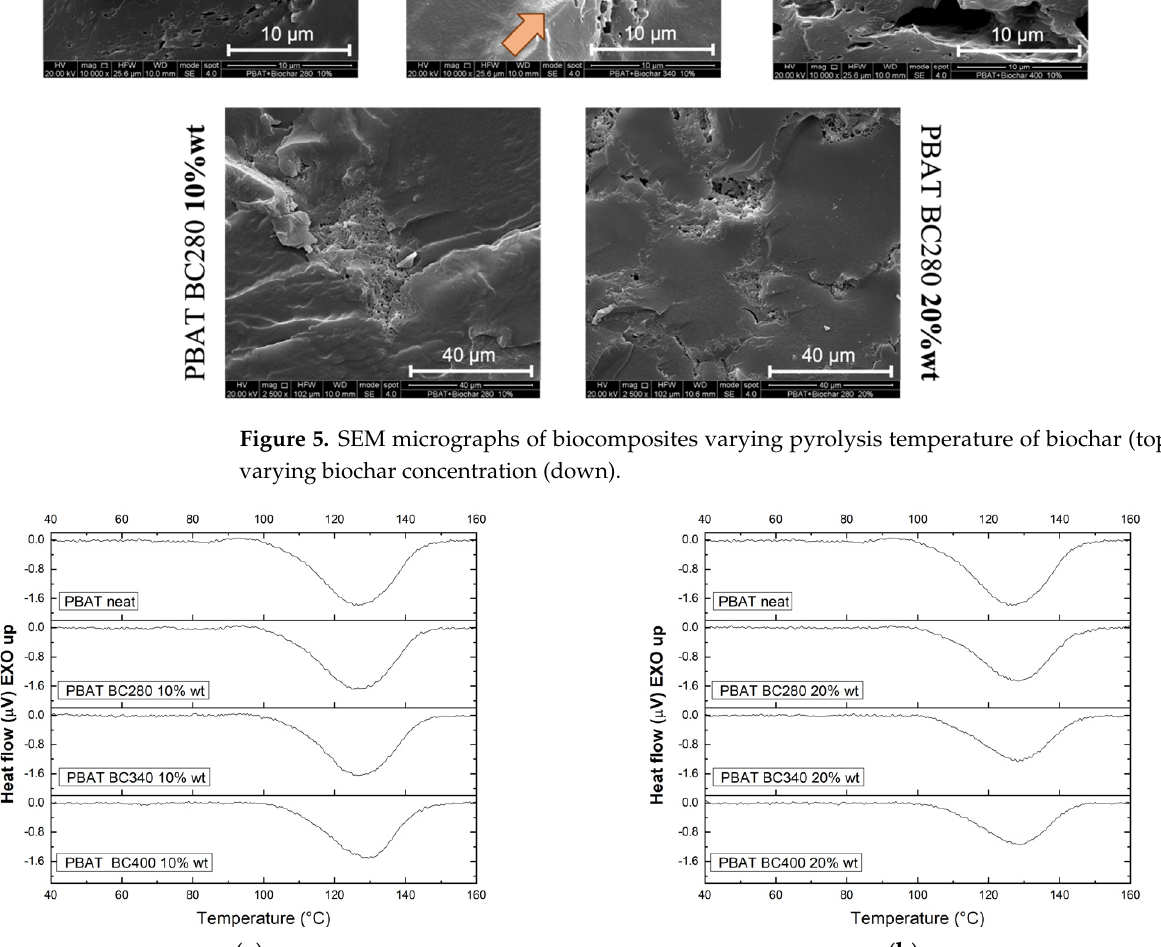
Figure 5. SEM micrographs of biocomposites varying pyrolysis temperature of biochar (top) and varying biochar concentration (down).